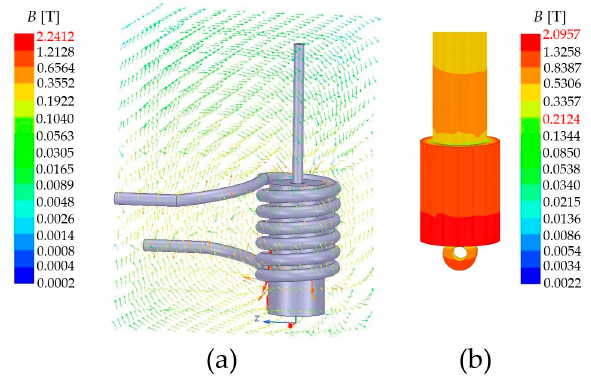
Figure 15. The magnetic flux density ( B ) with N = 6 for ( a ) an overview and ( b ) around the prod- uct.